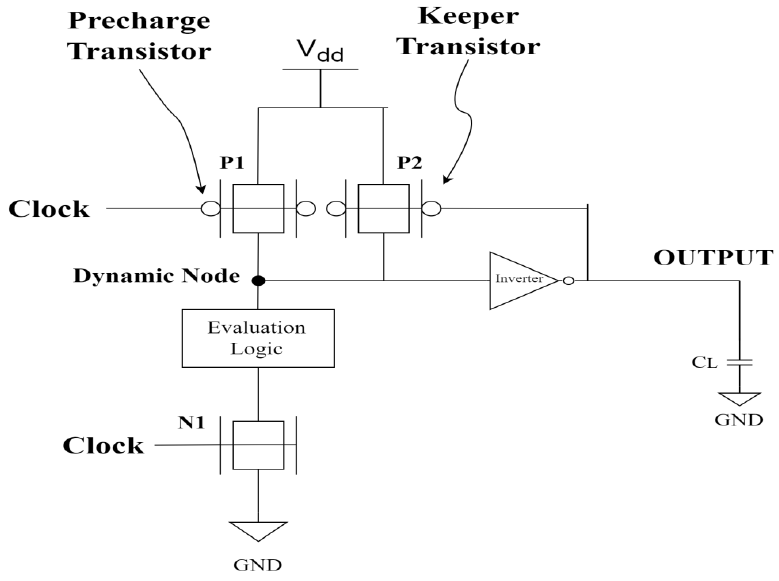
Figure 6. Logical dominos with foot (LDF) [26].